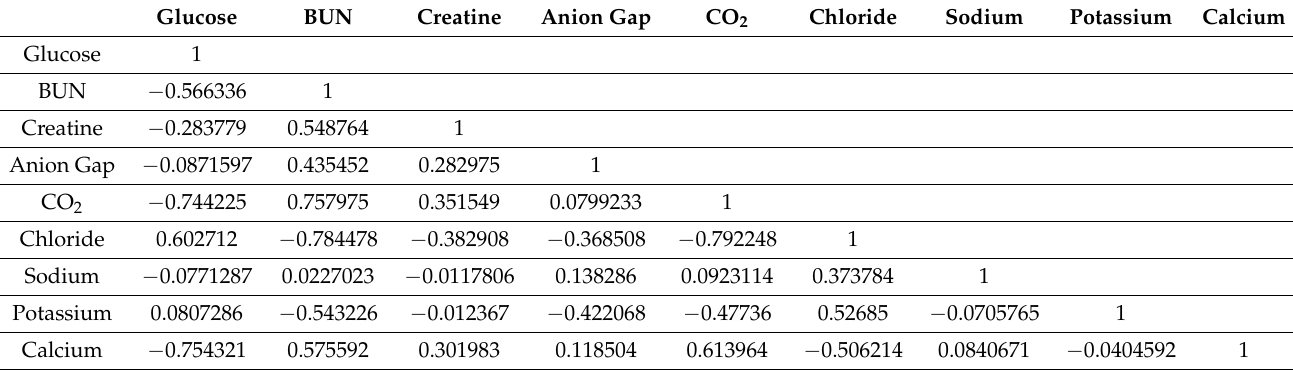
Table 1. Correlation coefficients of the 9 metabolic indices over the interpolated data